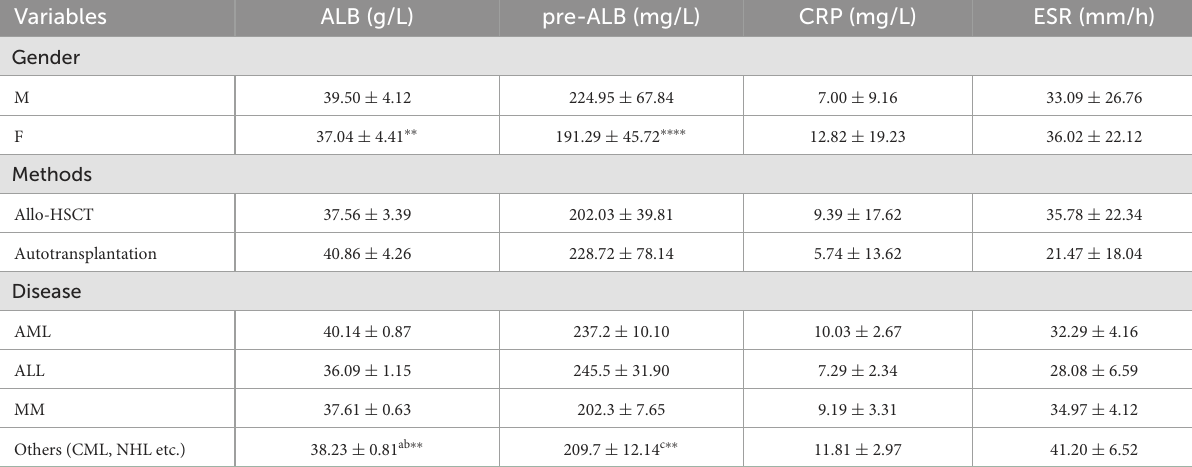
TABLE 3 Serum biomarkers in patients with different